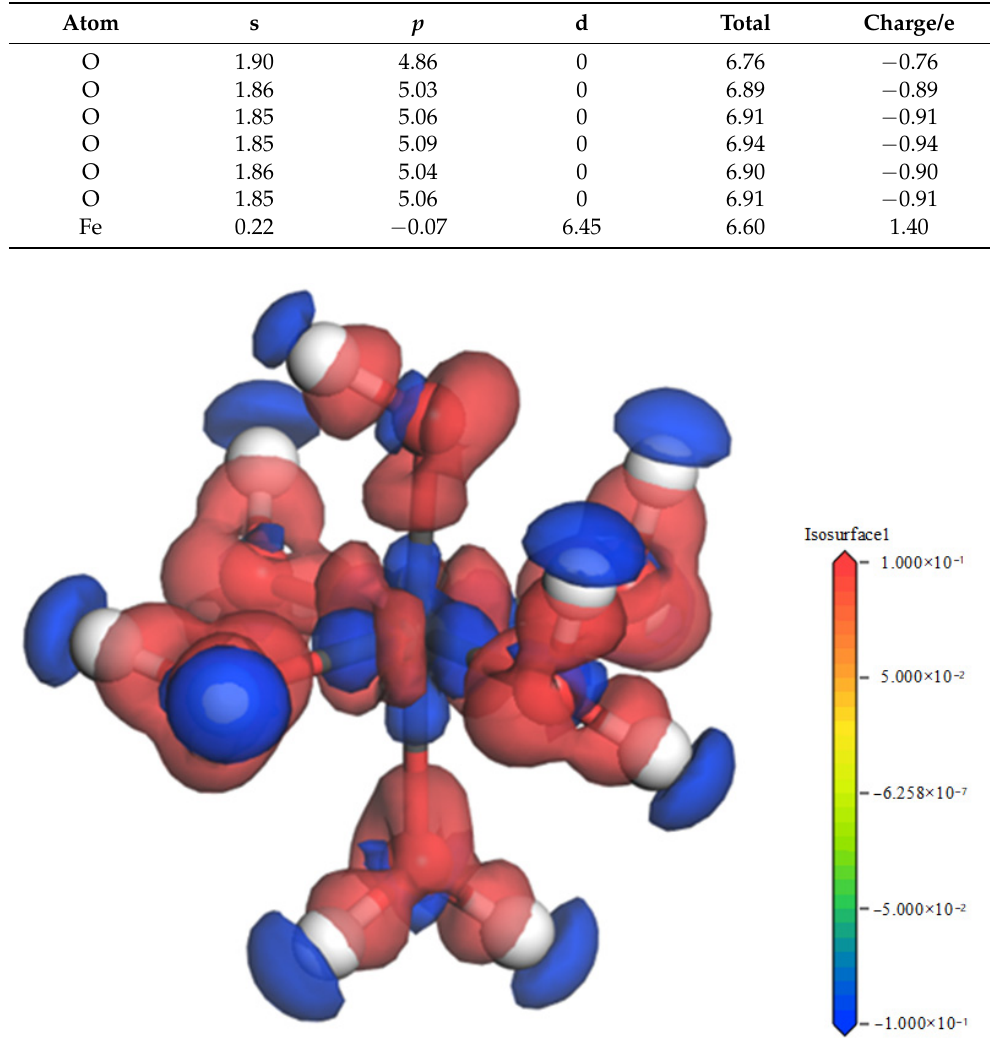
Figure 4. Picture of differential charge density of Fe(OH)(H 2 O) 52+ (isodensity is ±0.100 electrons/ Å 3 ).